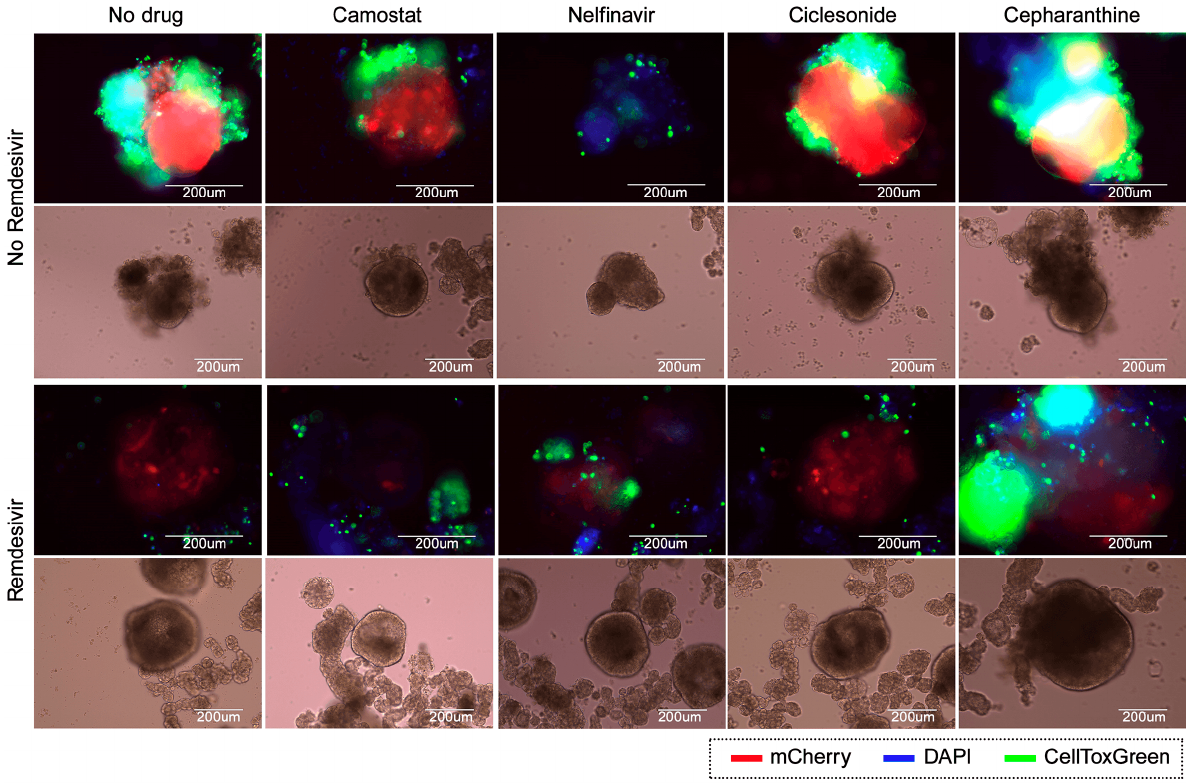
Figure 5. Evaluation of antiviral effects of drug combinations in human lung organoids (LOs). Fluorescent and bright-field analysis of drug or carrier-treated SARS-CoV-2-mCherry-infected LOs at 72 hpi (multiplicity of infection (MOI) 0.1). Virus infection, cell nuclei, and cytotoxicity are shown in red, blue, and green, respectively. Scale bars, 200 μ m.